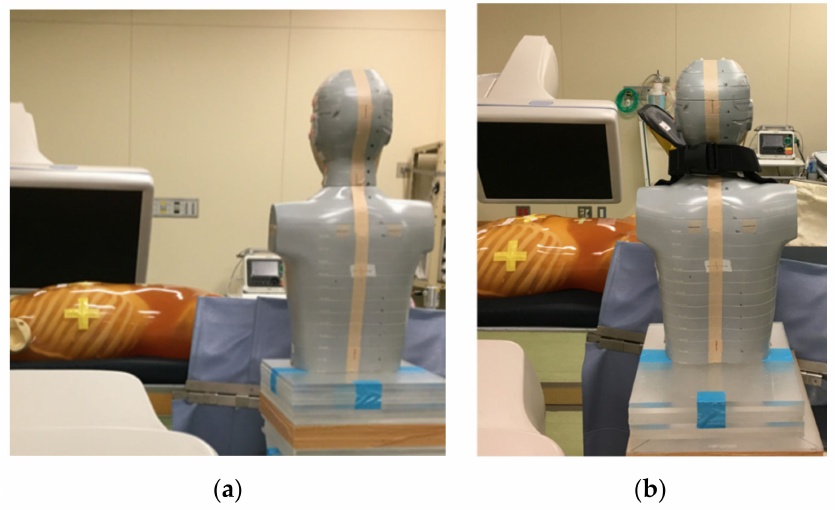
Figure 3. Experimental setup used for our phantom study (e.g., LAO60): ( a ) without novel shielding device; ( b ) with novel shielding